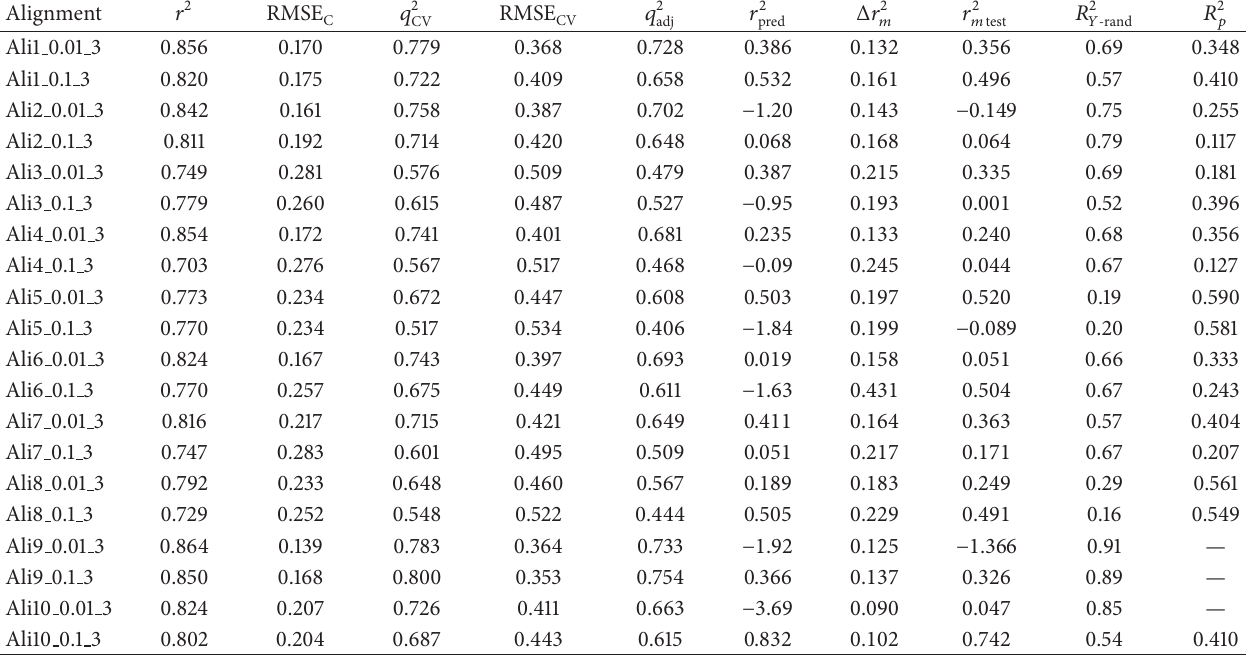
Table 3: Summary of the results of the best 4D-QSAR models obtained for the ten alignments with Test Group III and their respective cut. Alignment